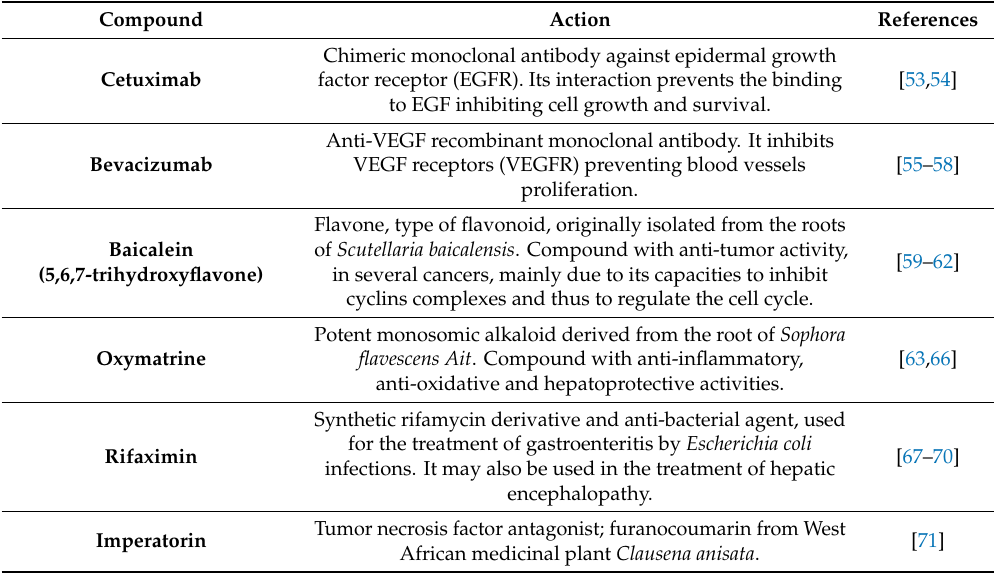
Table 1. Drugs and relative molecular